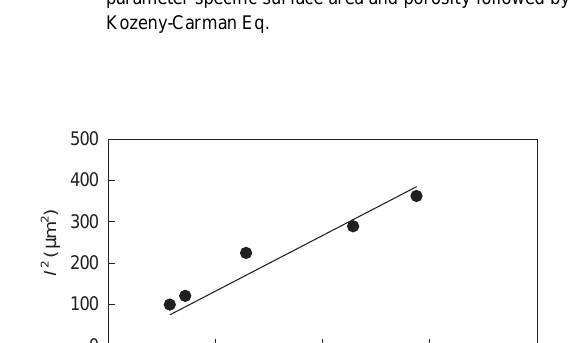
e 2 (10 (cid:2) 3 kg/m 2 ) (1 (cid:2) e )· S